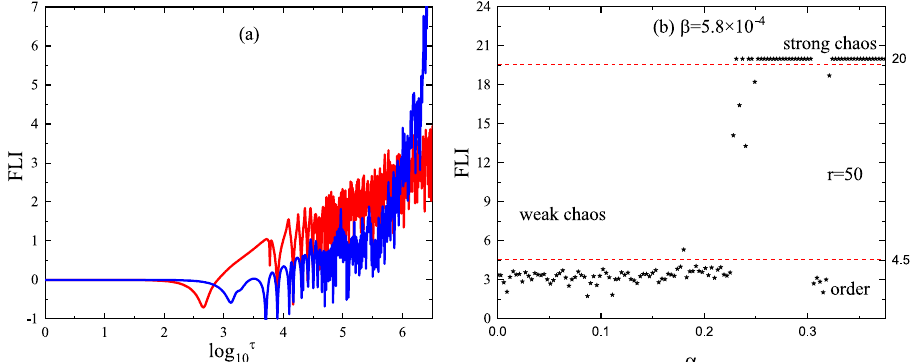
Figure 3. ( a ) Fast Lyapunov indicators (FLIs) for Orbits 1 and 2 in Figure 1a. The FLI grows slowly with time for the ordered orbit 1 (colored Red), but quickly for the chaotic orbit 2 (colored Blue). ( b ) Dependence of FLI on the modified gravity parameter α . The other parameters are the same as those of Orbit 1, and the initial separation is r = 50. Each value of the FLIs is obtained after the integration time reaches τ = 1 × 10 6 ; 4.5 is a threshold value of the FLIs between order and chaos. The FLIs smaller than (or equal to) this threshold show the regularity. However, the FLIs more than this threshold indicate the chaoticity. In this way, the values of α corresponding to order and those corresponding to chaos are clearly listed in this